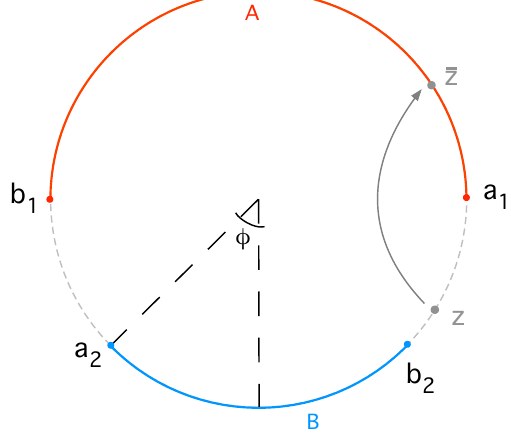
Figure 3 . Our setup for calculating the reflected entropy for a free fermion on a circle. Global conformal symmetry allows us to fix three of the four the interval endpoints A = [ a 1 , b 1 ] = [0 , π ] and B = [ a 2 , b 2 ] = [3 π/ 2 − φ, 3 π/ 2 + φ ] . The angle φ is related to the conformal cross-ratio by x = 2 sin φ/ (1 + sin φ ) . The modular conjugation for region A takes z → ¯ z , or equivilently θ → − θ after circular